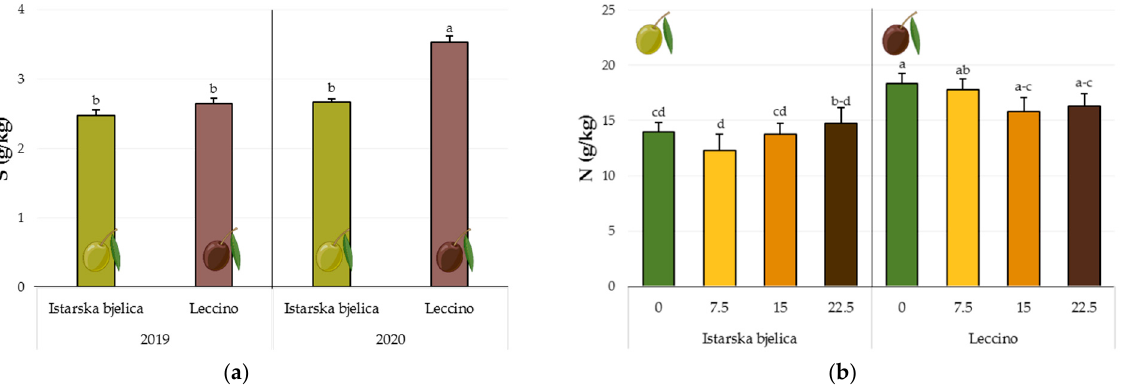
Figure 2. Multiple comparisons of the effects of ( a ) cultivar (Cv.) (Istarska bjelica, Leccino) and year (Y) (2019, 2020) on the concentration of sulfur (S), and ( b ) treatment (T) (0, 7.5, 15, and 22.5 mL of applied SN foliar fertilizer per 1 L of water) and cultivar on the concentration of nitrogen (N) in olive leaves. Different superscript lowercase letters represent statistically significant differences between mean values at p < 0.05 obtained by a three-way ANOVA and Tukey’s test.